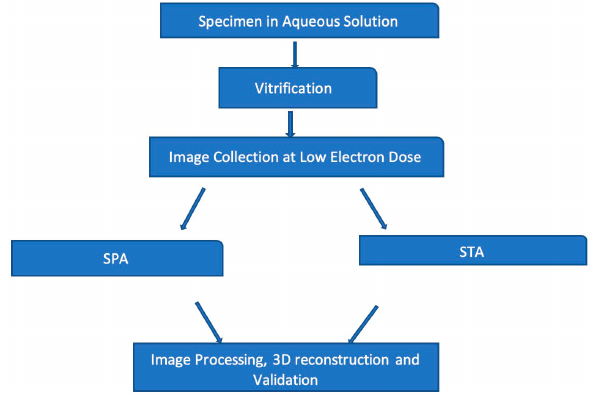
Figure 1. Basic workflow of Cryo-Electron Microscopy (Cryo-EM). Image collected at low dose electron can be analyzed by single-particle or sub-tomogram averaging. However, samples must be vitrified by flash ‐ freezing.